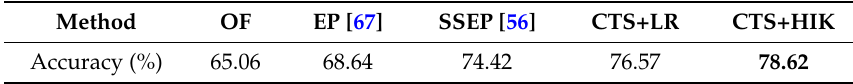
Table 8. Classification accuracy comparison on Scene-TA with ten training samples per